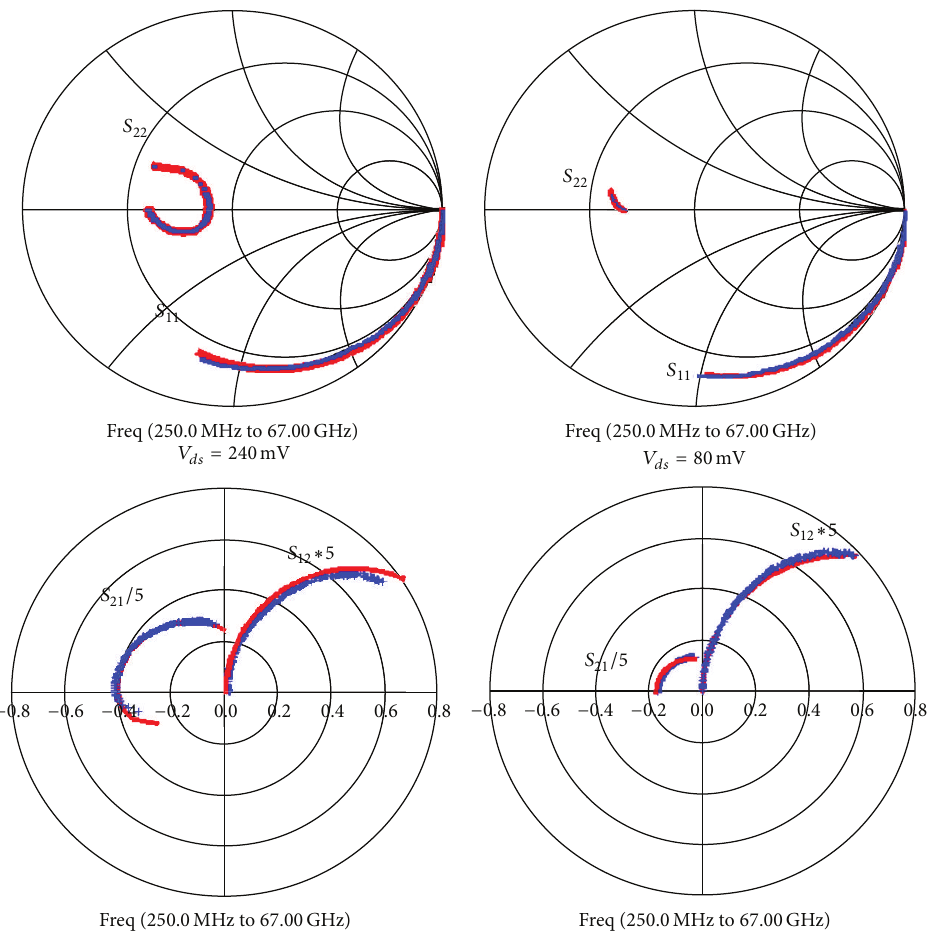
Figure 7: 𝑆 -parameters measured (blue dots) and simulated (red curves) at 𝑉 𝑑𝑠 = 80 mV and 𝑉 𝑑𝑠 = 240 mV. 𝑉 = 240 mV with such low-power consumption. 𝑑𝑠